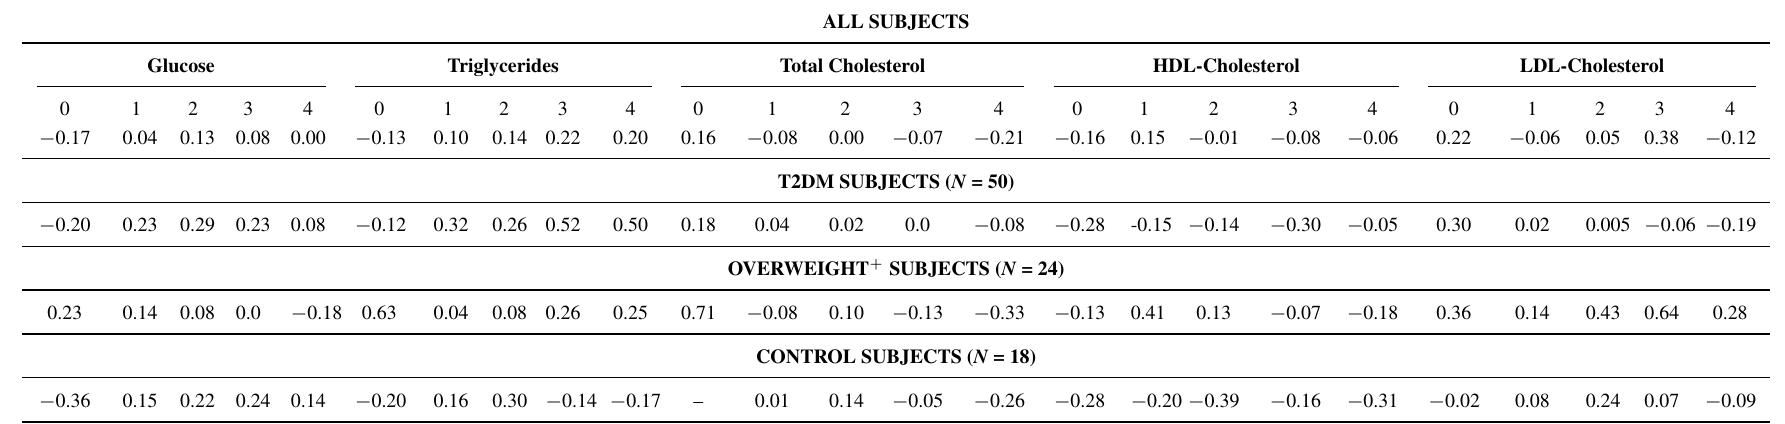
Table 3. Bivariate associations between lipids, glucose and